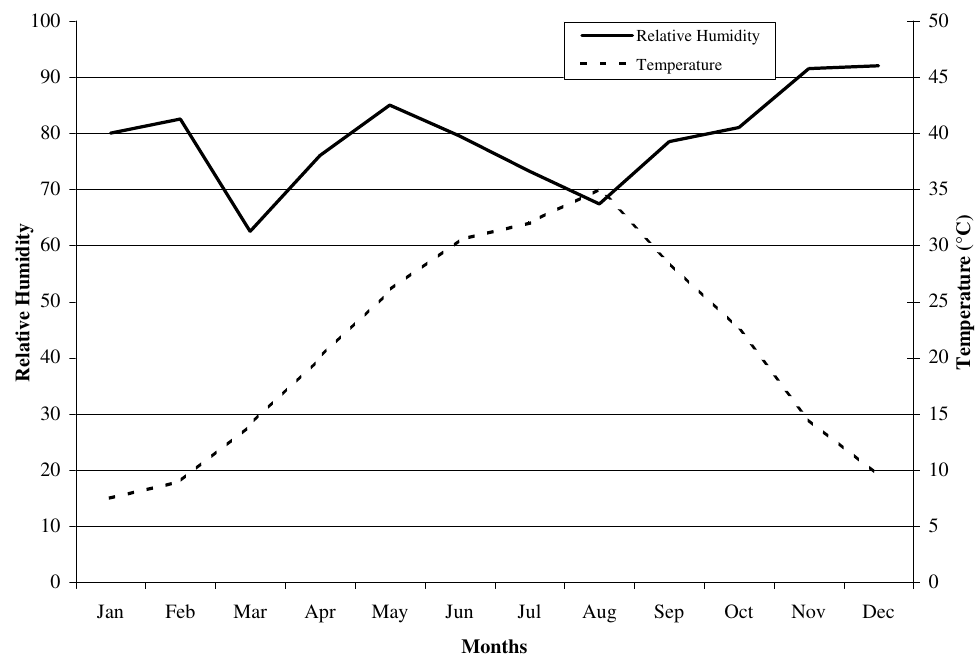
Fig. 1. Average monthly temperature and relative humidity recorded at Ulignano (Pisa) in 2004 and